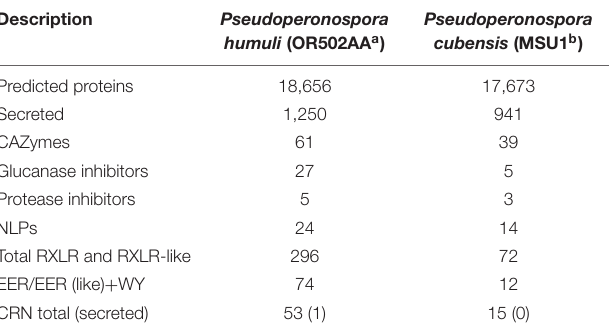
TABLE 1 | Comparison of secretome and effector families in Pseudoperonospora humuli and Pseudoperonospora